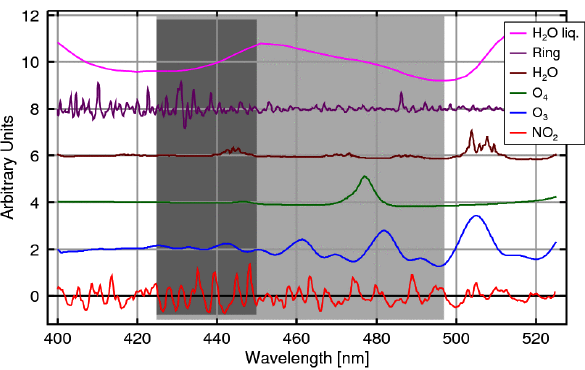
Fig. 4. Average fitting residual (chisquare) for all GOME-2 stan- dard NO 2 retrievals in August 2007. Larger values at high southern latitudes are the result of low intensities. At a certain solar zenith angle threshold, the integration time of GOME-2 measurements is increased, leading to smaller residuals at the highest southern lati- tudes.